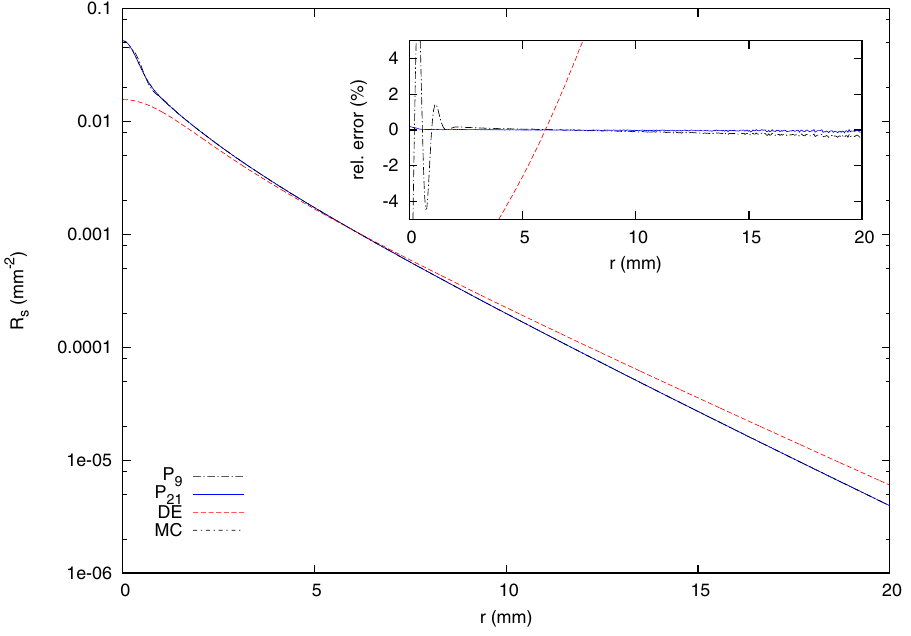
Figure 5. Steady-state spatially resolved reflectance from the three-layered scattering medium, but with (1) 1 and µ ′ = . − 2 0mm (3) 1 . All other parameters are equal to interchanged scattering coefficients µ ′ = . − 0 5mm s s those of Fig. 4. Due to the large transport length in the thin upper layer, the DE solution becomes unusable, whereas the multi-layer RTE solution still produces accurate